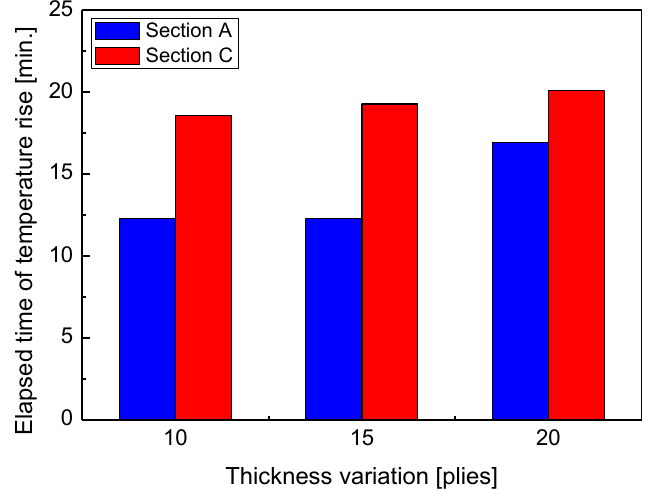
Figure 8. Elapsed time of temperature rise with thickness variation.